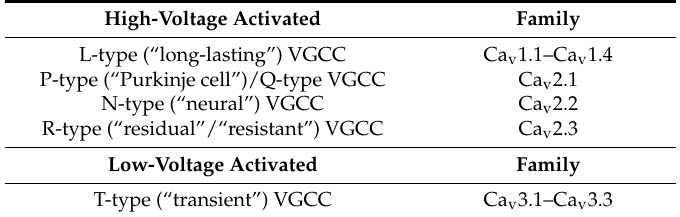
Table 1. Classification of voltage-gated calcium channels (VGCCs) according to their voltage-dependent activation.